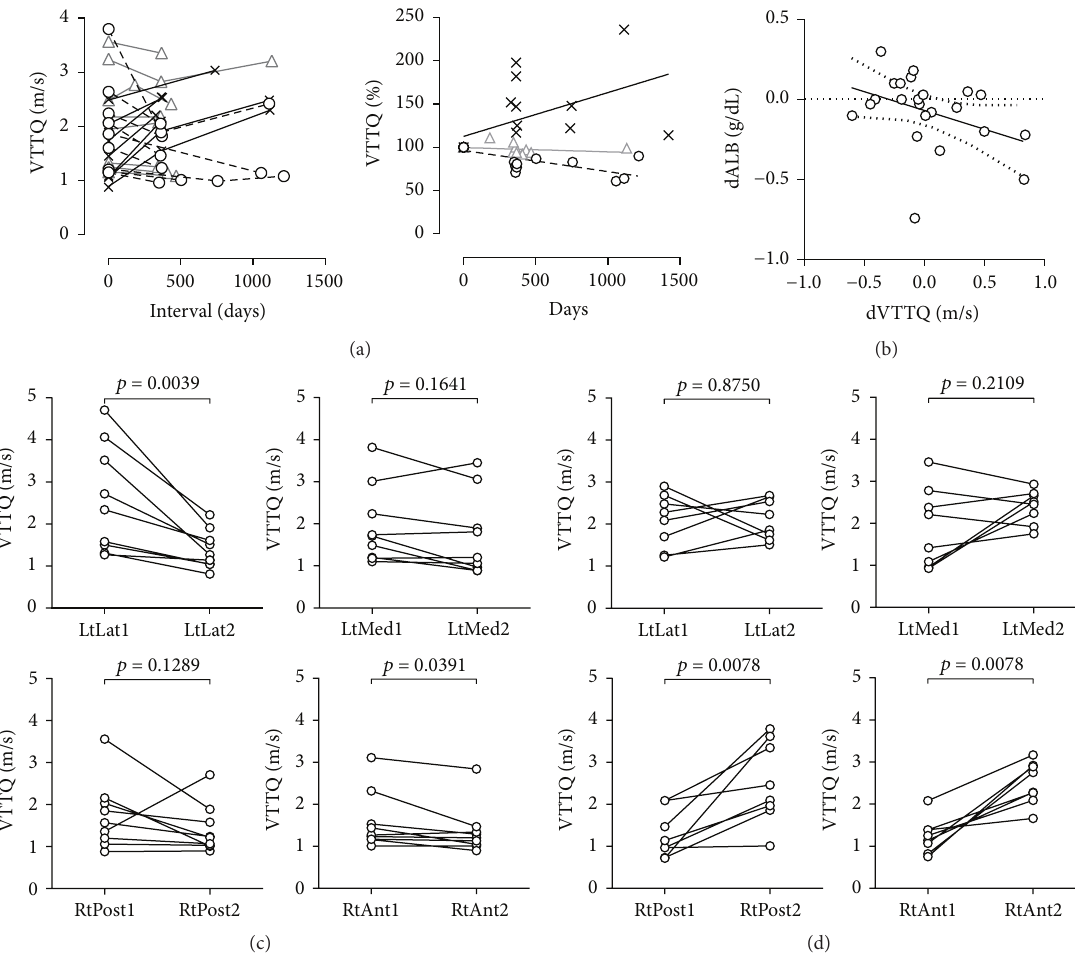
Figure 4: Characteristics of VTTQ in time and space during the course of NAFLD. (a) A plot of sequential measurements of VTTQ (median) in m/sec (left) or percentage to the first measurement (right). Cases with VTTQ getting smaller (circle), larger (cross), or stable (triangle). The lines of the right column reveal the best hit for each group (continuous for cross, dotted for circle, and grey for triangle). (b) The correlation between the alteration rates of VTTQ (dVTTQ) and serum albumin concentration (dALB) per year (continuous line, best hit; dotted line, 95% confidence). ((c) and (d)) VTTQ values of the first (1) and second (2) measurements at each segment: lateral (LtLat), medial (LtMed), posterior (RtPost), and anterior (RtAnt), in the cases with VTTQ of the entire liver getting smaller (c) or larger (d) in a follow-up period.